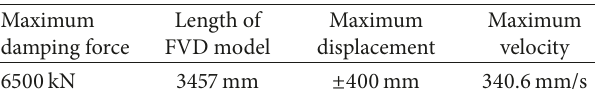
Table 2: Main parameters of the FVD